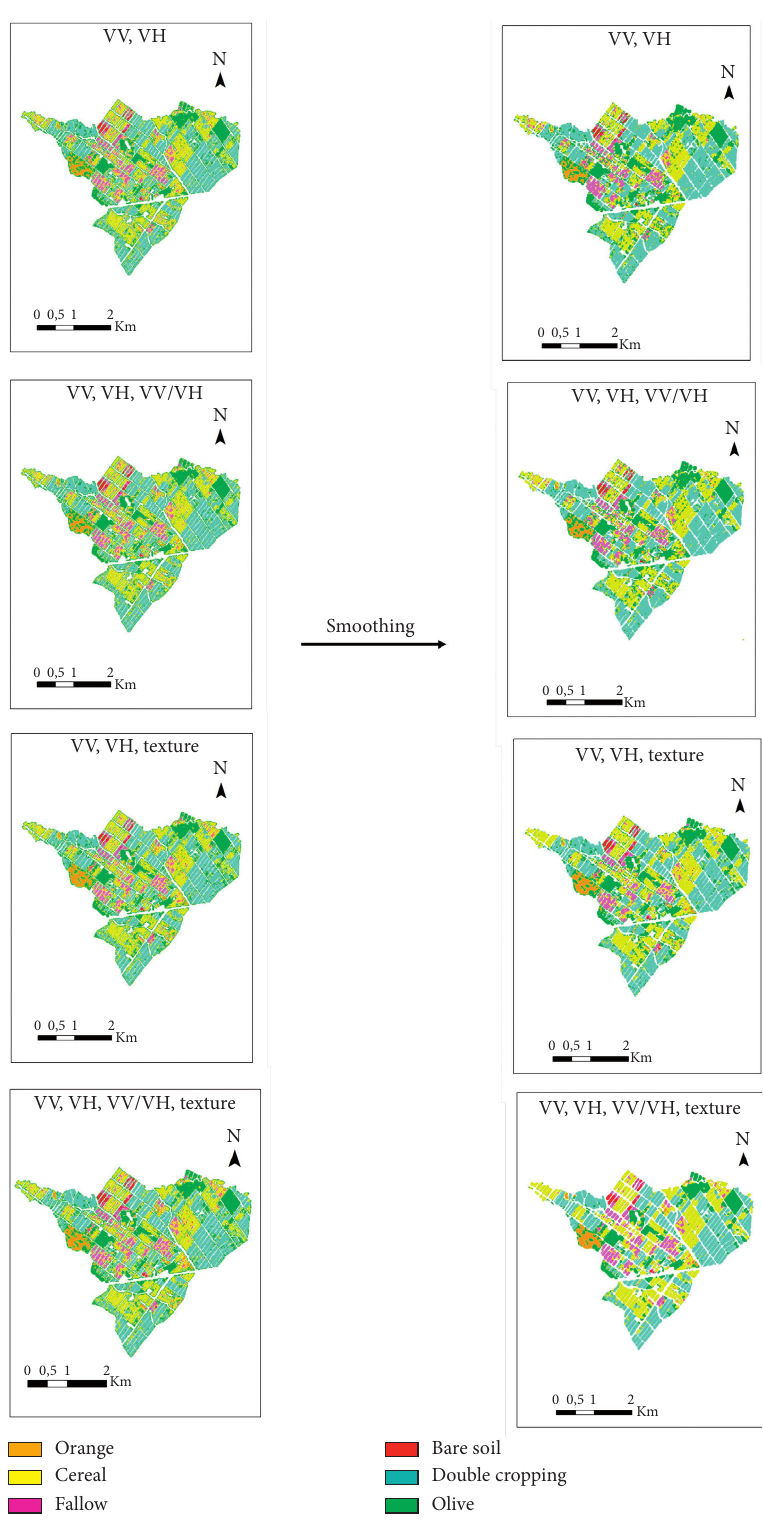
Figure 11: Smoothing of 4 SAR classification scenarios (VV; VH), (VV; VH; texture), (VV; VH; VV/VH), and (VV; VH; VV/VH;